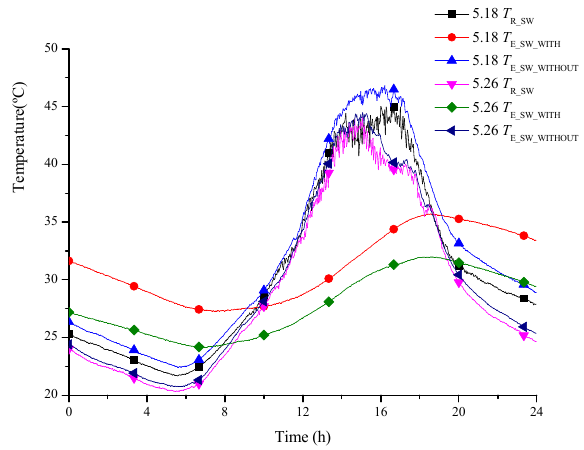
Figure 11. Temperature comparison diagram of south-facing wall. Table 4. Main data of temperature comparison of south-facing wall.